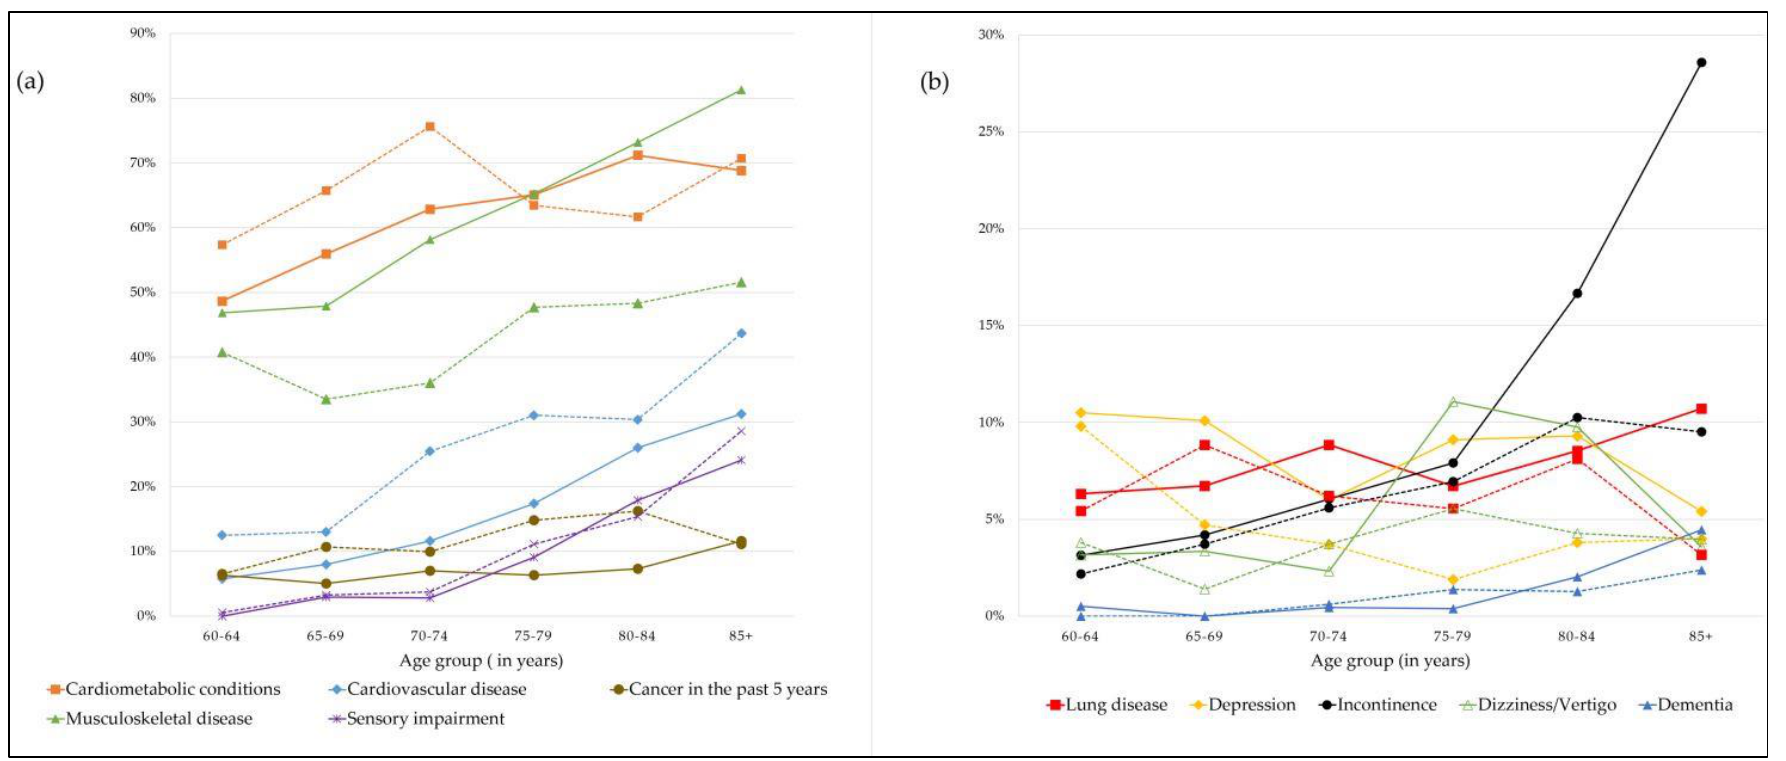
Figure 1. Prevalence of disease categories by age groups for women (solid lines) and men (dotted lines). ( a ) Disease categories: Cardiometabolic conditions, cardiovascular disease, cancer in the past five years, musculoskeletal disease, and sensory impairment. ( b ) Disease categories: lung disease, depression, incontinence, dizziness/vertigo, and dementia.